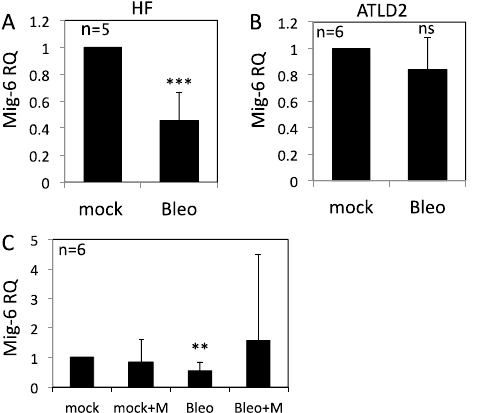
Figure 3. Regulation of Mig-6 expression by DNA damage. HF cells ( A ), ATLD2 cells ( B ), or HF cells that were pre-treated with mirin (100 µM) for an hour ( C ), were either left untreated or treated with bleomycin for 30 min and then RNA was extracted. Mig-6 mRNA expression level was determined by qRT-PCR and normalized to GAPDH. Graphs show an average (± STD) of the indicated number of independent experiments in each group. The expression of Mig-6 in control cells was set as 1. **p < 0.005; ***p < 0.0001; ns: